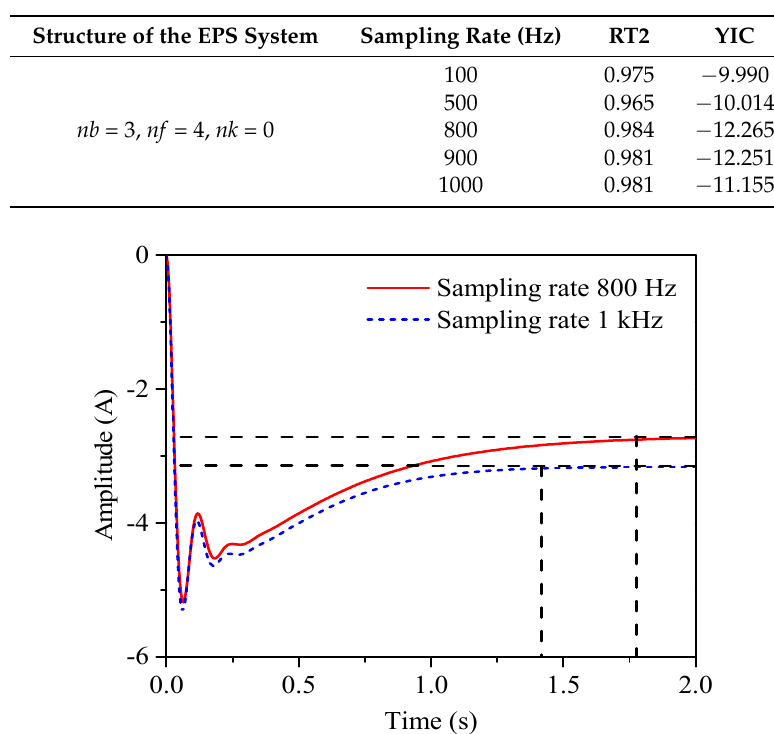
Table 9. Evaluation parameters at different sampling rates.